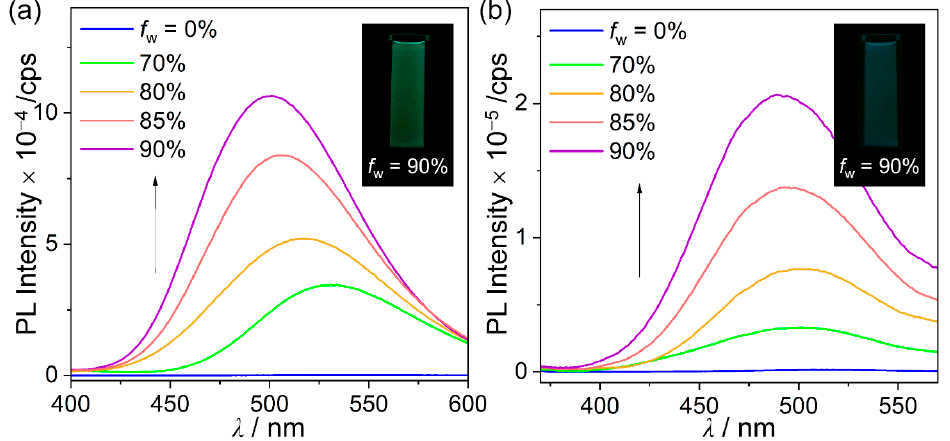
Figure 4. PL spectra of (a) 15CS ( λ ex = 329 nm) and (b) 26CS ( λ ex = 333 nm) in THF/distilled water mixtures (50 µM). Inset figures show the emission color in each state under irradiation by a hand-held UV lamp ( λ ex = 365 nm).